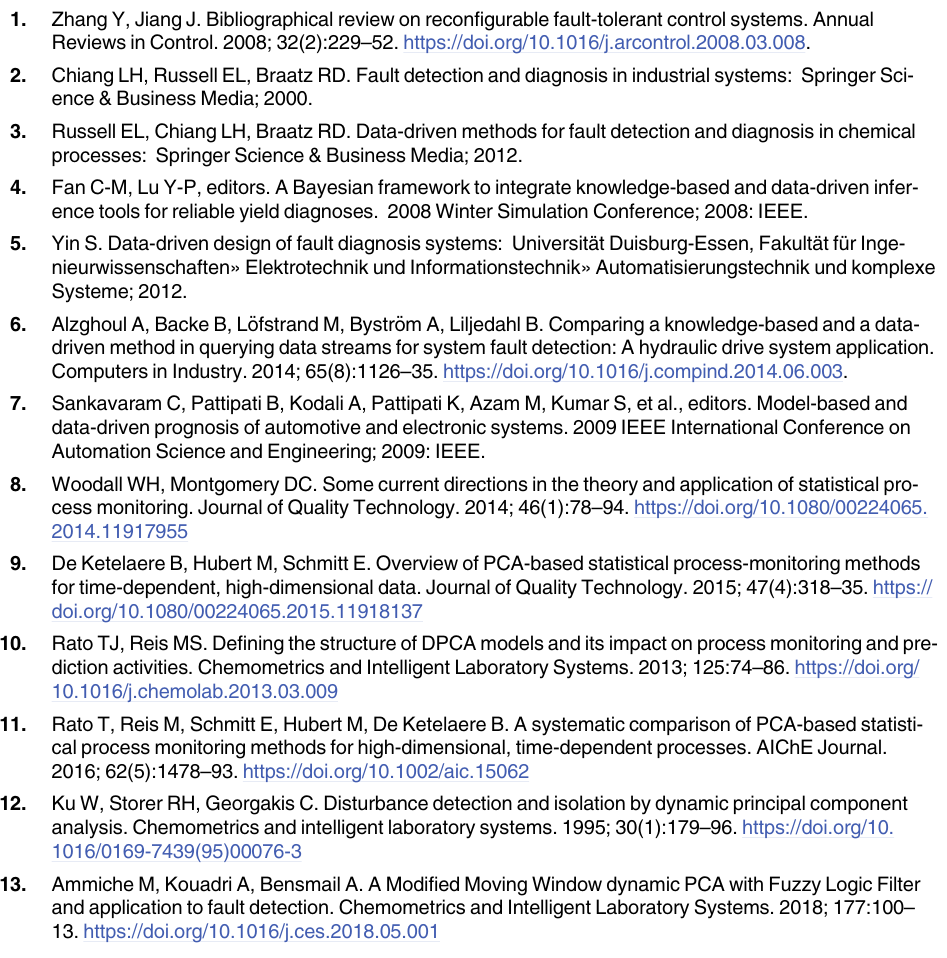
S7 Fig. Monitoring performance of MWDPCA for fault 11. (TIF) S8 Fig. Monitoring performance of MWDPCA for fault 15. (TIF) S9 Fig. Monitoring performance of MWDPCA for fault 16. (TIF) S10 Fig. Monitoring performance of MWDPCA for fault 19. (TIF) S11 Fig. Monitoring performance of MWDPCA for fault 20.